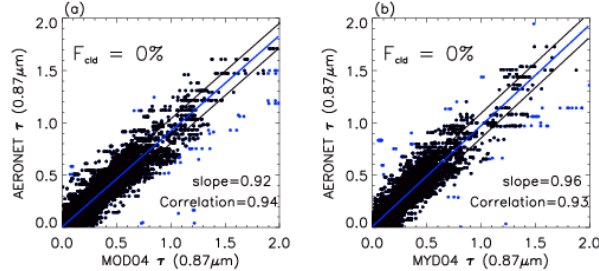
Fig. 1. Scatter plots of MODIS versus AERONET level 2.0 AOD at 0.87µm under cloud free conditions with correlation and slope of the linear regression. Blue lines are linear regression lines through the data points and the black lines show the 95% confidence interval of the blue lines. Blue dots represent the outliers that have an abso- lute difference between MODIS and AERONET AOD larger than 0.4. (a) for C5 Terra AOD, year 2000–2008, and (b) for C5 Aqua AOD